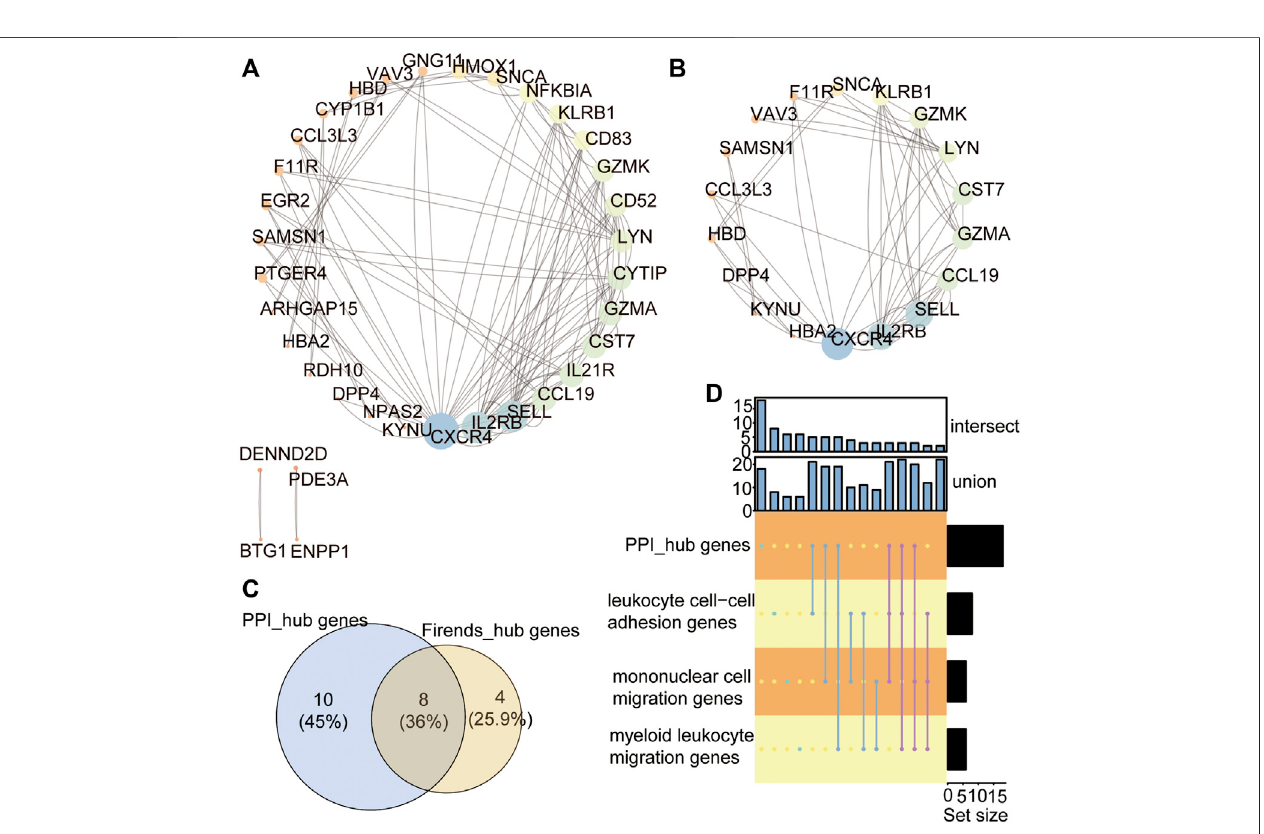
FIGURE 7 | Protein-Protein interaction network analyses of the IRDEGs. (A) PPI network showing the protein-protein interaction coded by IRDEGs. (B) The PPI_hub_genes with therank > 10. (C) Venn showing the8hubgenesbetweenthePPI_hub_genes and functionalsimilarities_hub_genes. (D) The intersection ofgenes in PPI hub genes and in GO terms of top